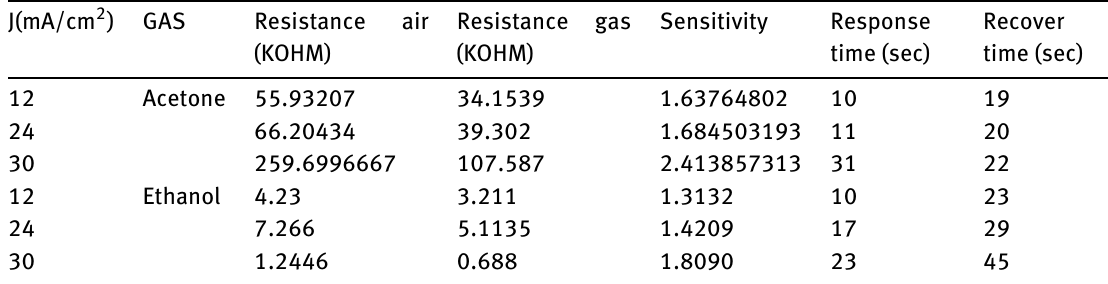
Table 3: The modified samples’ recovery and response